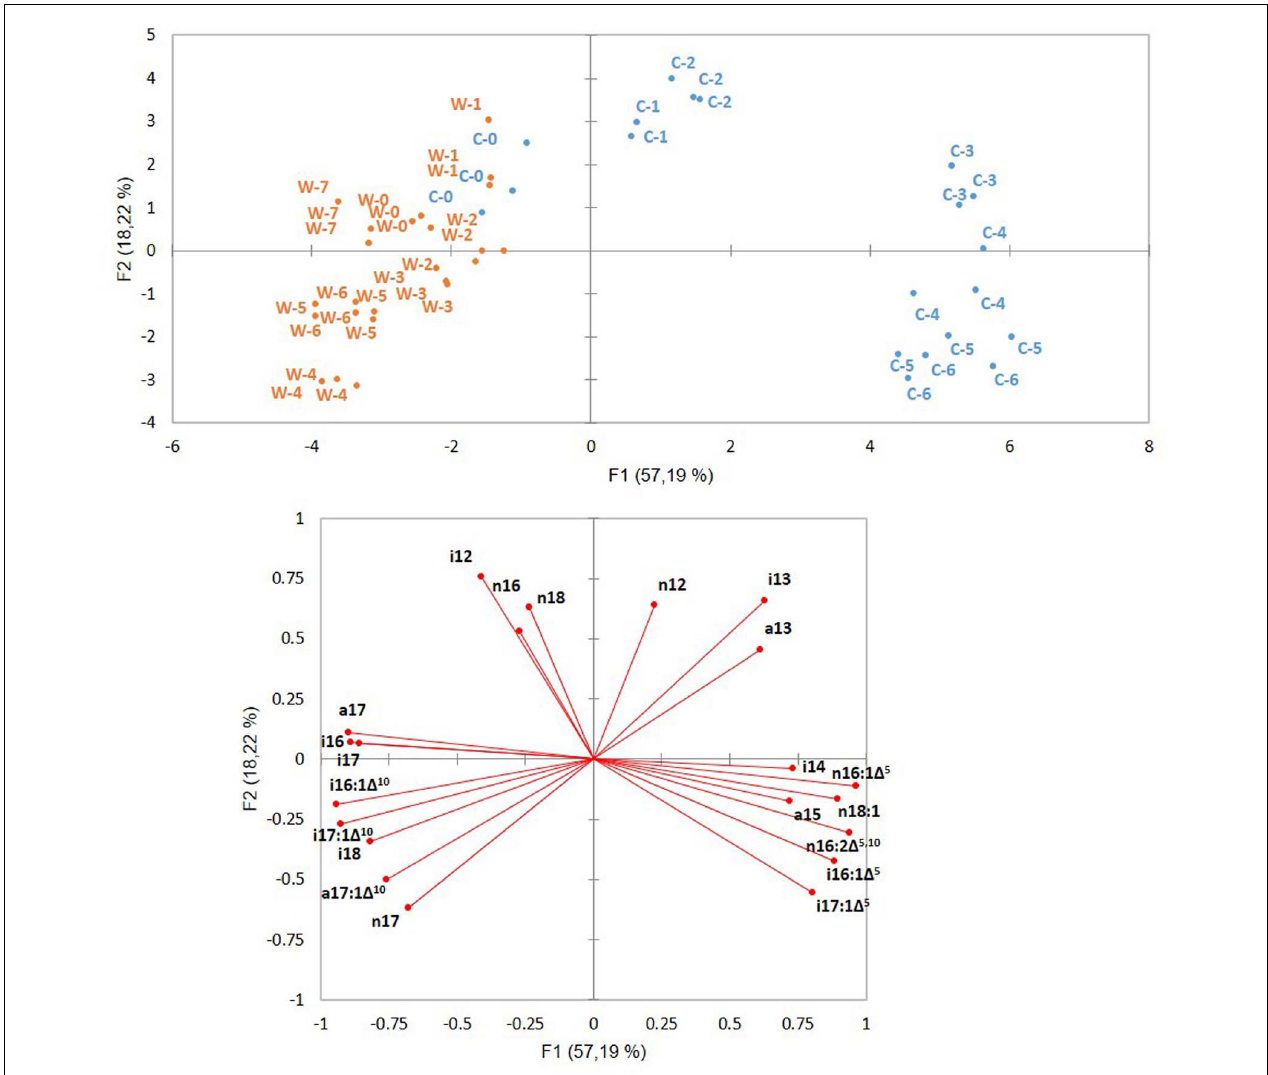
FIGURE 3 | Principal component analysis of B. cereus ATCC 10876 samples grown at warm (W) and cold (C) temperatures. Samples were grown for 0, 3, 7, 24, 48, 72, and 96 h at cold (corresponding to samples C0 to C6, blue points) and 0, 0.5, 1, 2, 4, 6, 7, and 24 h at warm temperatures (corresponding to samples W0 to W 7, orange points). Inoculum at both cold (C0) and warm (W0) growth experiments were grown at a warm temperature. Distribution of samples (upper panel) and position of variables (lower panel). Variables were relative abundances of fatty